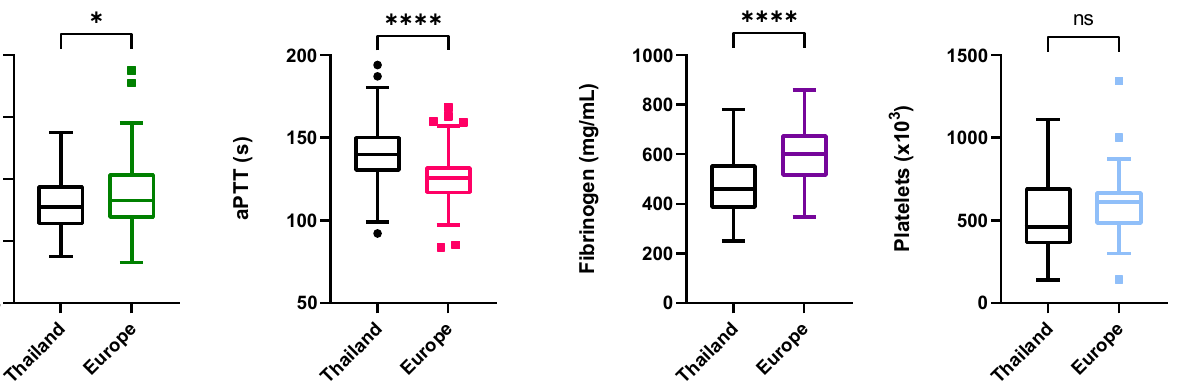
Figure 1. Boxplot representation of the PT, aPTT, fibrinogen, and platelets values grouped by study region. The box represents the 25th–75th percentile values of the distribution (interquartile range), the line within the box represents the median (50th percentile), and the whiskers approximate the 2.5th and 97.5th percentile values. Stars indicate significance threshold. *: p < 0.05, ****: p < 0.0001; ns—not significant.